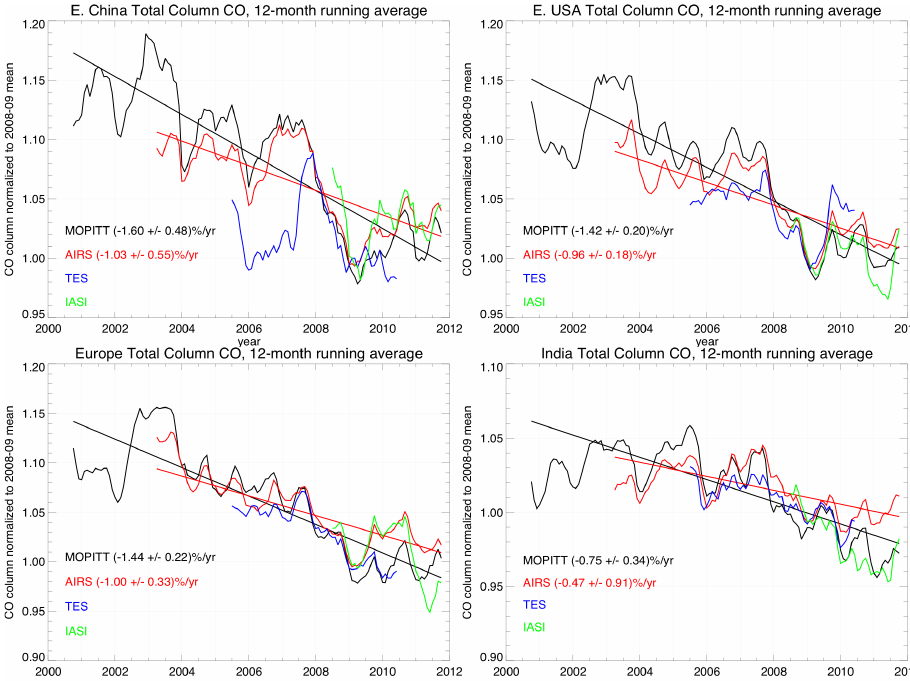
Figure 8. Fig. 8. 12-month running averages for total column CO measurements over E. China. E. USA, Europe and India, normalized by the 08/2008– 07/2009 average CO column for each instrument. See text for description of TES bias due to limited sampling, especially for China during